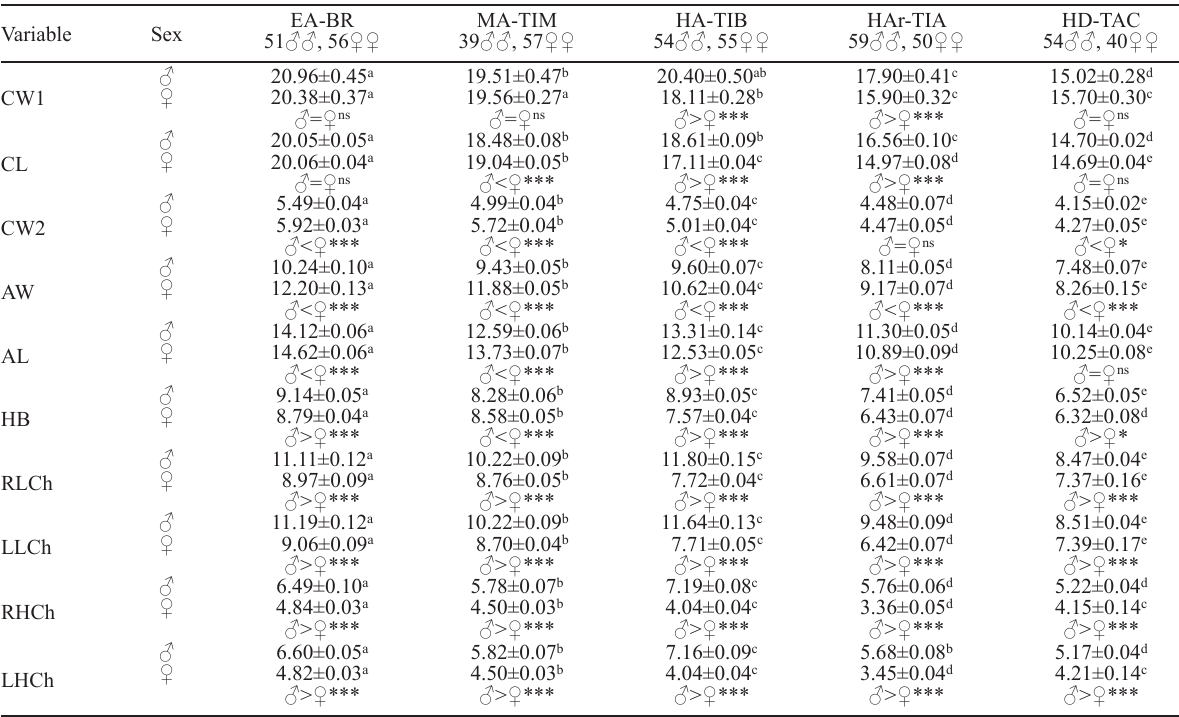
Table 1. – Mean values (±se) of morphometric variables (mm) of males (♂♂) and females (♀♀) of A. pisonii . Abbreviations: EA- BR, estuarine arboreal mangrove of Boca de Ricoa; MA-TIM, marine arboreal mangrove of Tiraya Marina; HA-TIB, hypersaline arboreal mangrove of Tiraya B; HAr-TIA, hypersaline arbustive mangrove of Tiraya A; and HD-TAC, hypersaline dwarf mangrove of Tacuato. Different letters indicate groups with significant differences between sites according to pairwise comparison (PERMANOVA, P<0.05). ns=not significant,